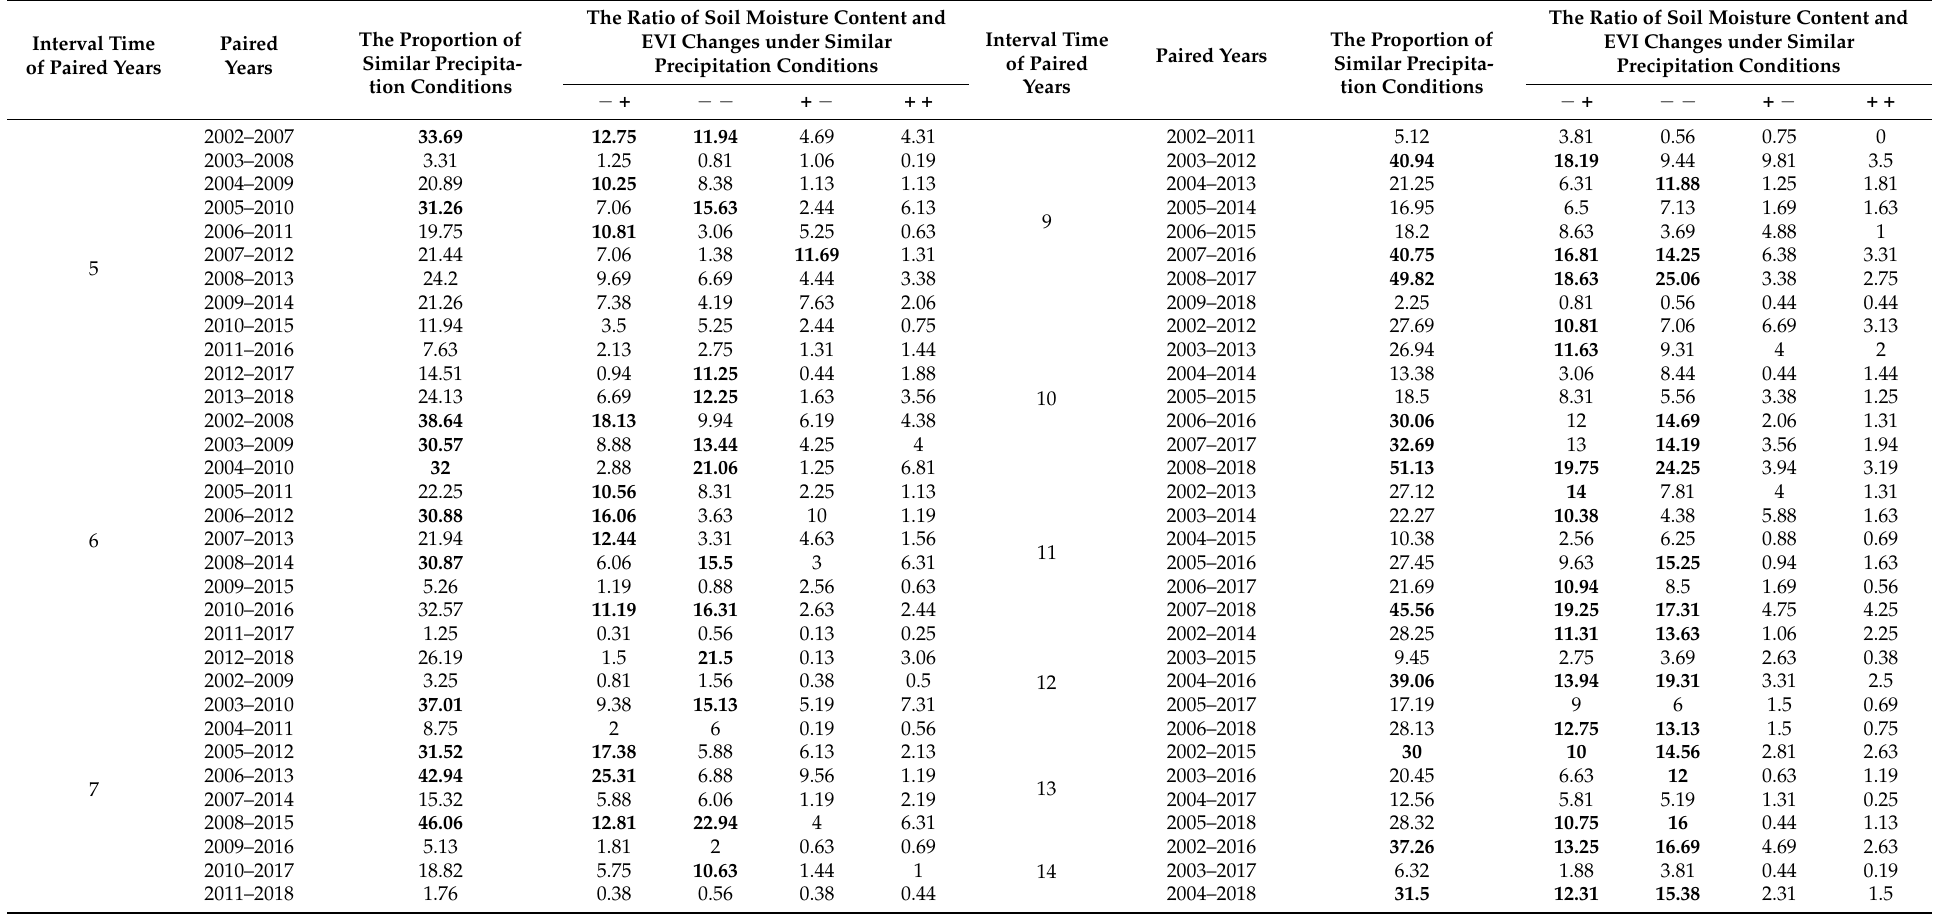
Table 6. The proportion (%) of similar precipitation conditions and interaction variation trends of EVI and soil moisture content in the paired years with similar precipitation conditions in the humid karst areas during 2002–2018 (“ − +” means soil moisture content decreased while EVI increased, “ − − ” means soil moisture content decreased while EVI decreased, “+ − ” means soil moisture content increased while EVI decreased, “+ +” means soil moisture content increased while EVI increased, a more detailed description of the classes can be seen in Table